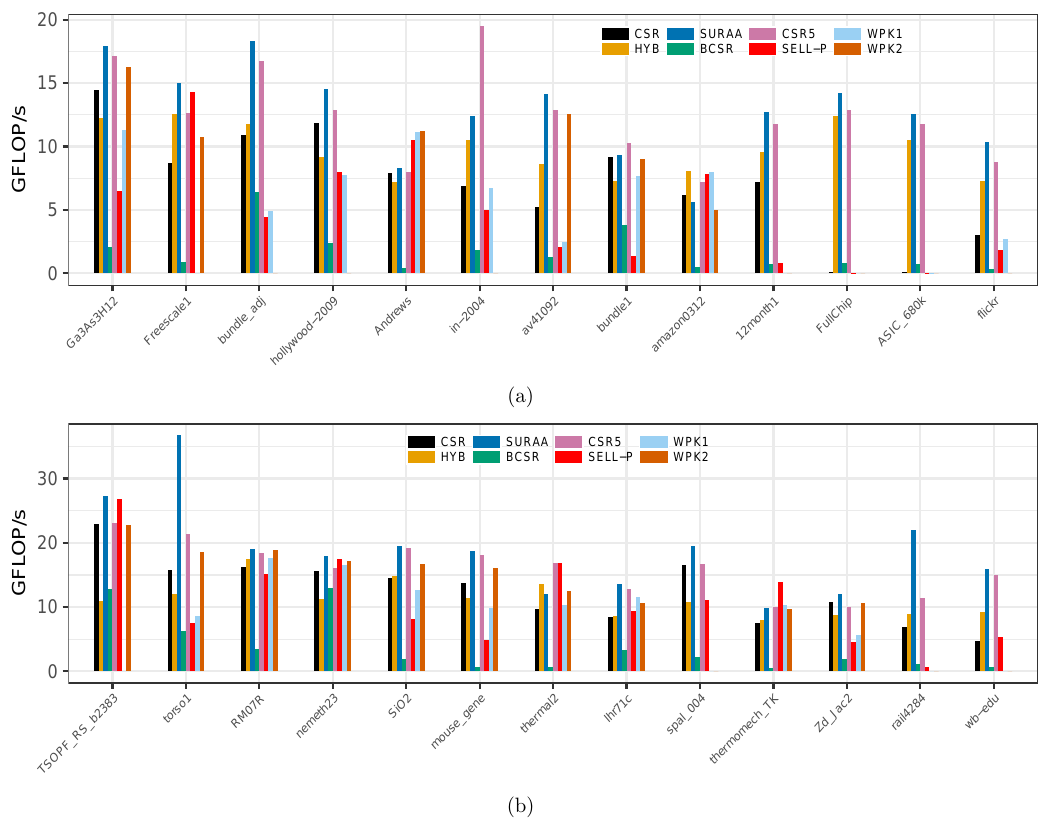
Figure 7. SURAA: throughput comparison with the state of the art commercial (cuSPARSE) and open source (CUSP, MAGMA) tools: CSR, HYB, BCSR, CSR-5, SELL-P, WPK1, and WPK2 for ( a ) the 13 matrices from the benchmark set that provided lowest throughput and ( b ) the 13 matrices that provided the highest throughput for